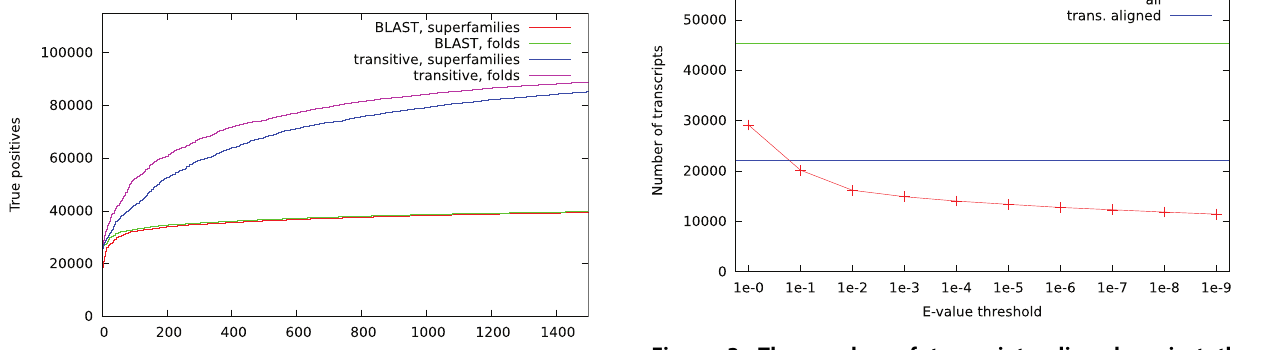
Figure 3. The number of transcripts aligned against the SwissProt database using increasing E -value threshold. For comparison, the total number of transcripts (45 360), and the number of transcripts annotated using transitive alignments with BLAST E -values of 10 { 4 (22 162) are also shown.